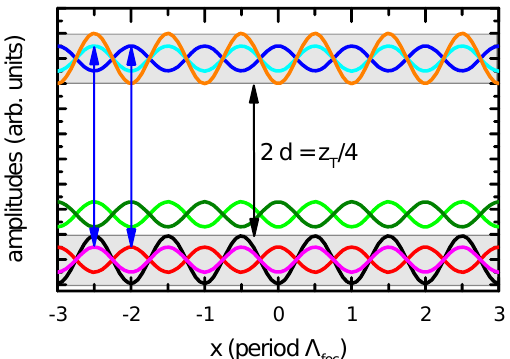
Figure 9. Illustration of feedback loop for single-mirror feedback for magnetic dipole interactions (see caption of Figure 2 for general explanation). Black line: orientation w . For red detuning: red (magenta) line: refractive index for σ − ( σ + ) light, light (dark) green line: phase modulation of transmitted σ − ( σ + ) beam, dark (light) blue: intensity of σ − ( σ + ) beam after a quarter of the Talbot distance, orange: difference pump rate D